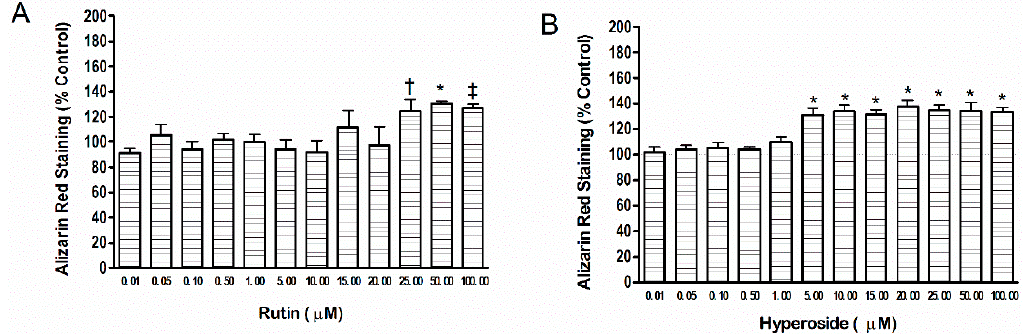
Figure 1. Mineral content produced by addition of ( A ) rutin or ( B ) hyperoside. Mineral content was measured by alizarin red staining. Significant differences are indicated by: † p < 0.05, ‡ p < 0.01, * p < 0.001 compared to control. Each bar represents n = 6.